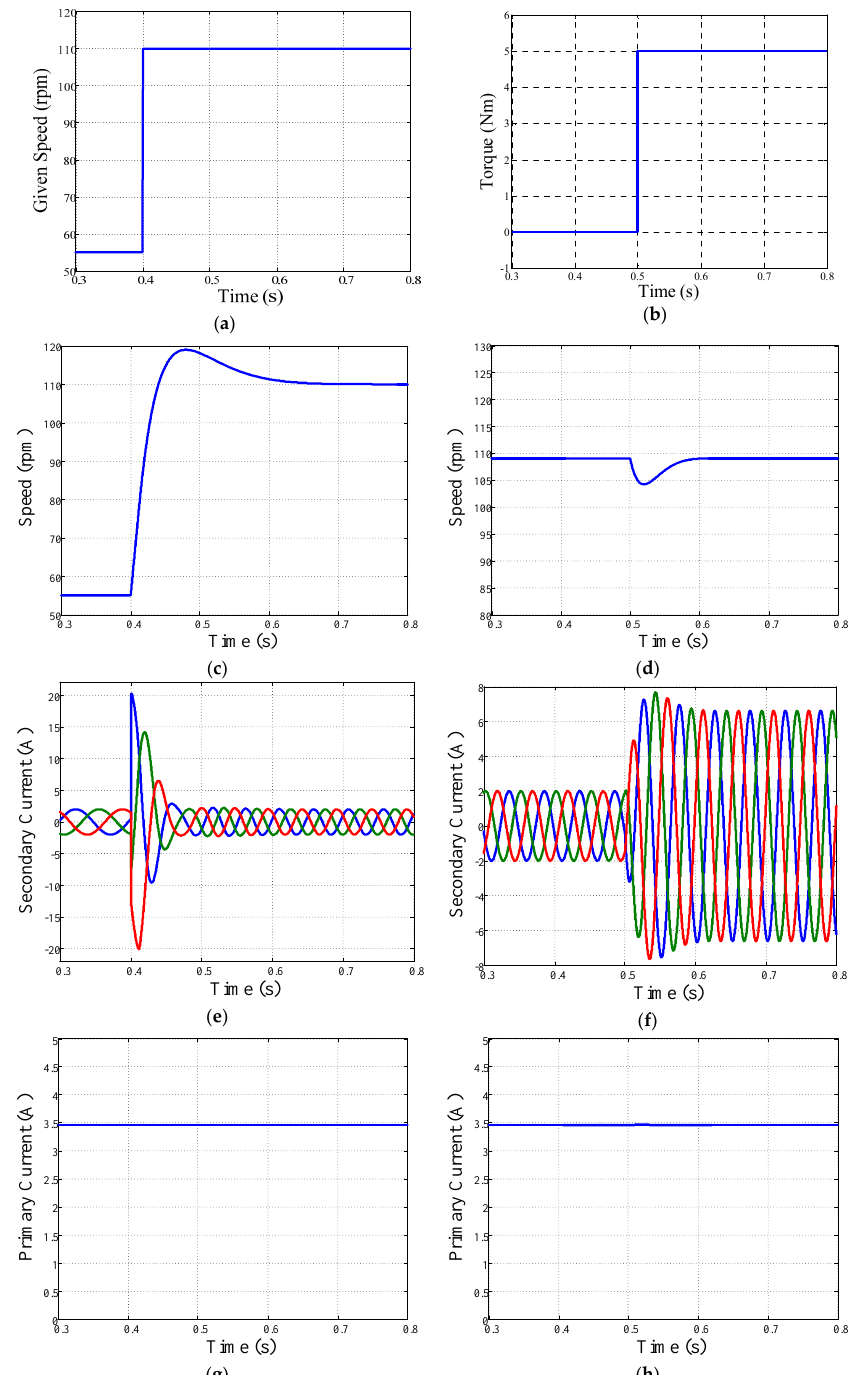
Figure 9. Simulation results of the DC excitation control for the DSFM motor: ( a ) curve of the given speed variation; ( b ) curve of the load torque variation; ( c ) speed curve for speed varying from 55 to 110 rpm; ( d ) speed curve for torque varying from 0 to 5 Nm; ( e ) secondary current curve for speed varying from 55 to 110 rpm; ( f ) secondary current curve for torque varying from 0 to 5 Nm; ( g ) primary current curve for speed varying from 55 to 110 rpm; and ( h ) primary current curve for torque varying from 0 to 5 Nm.